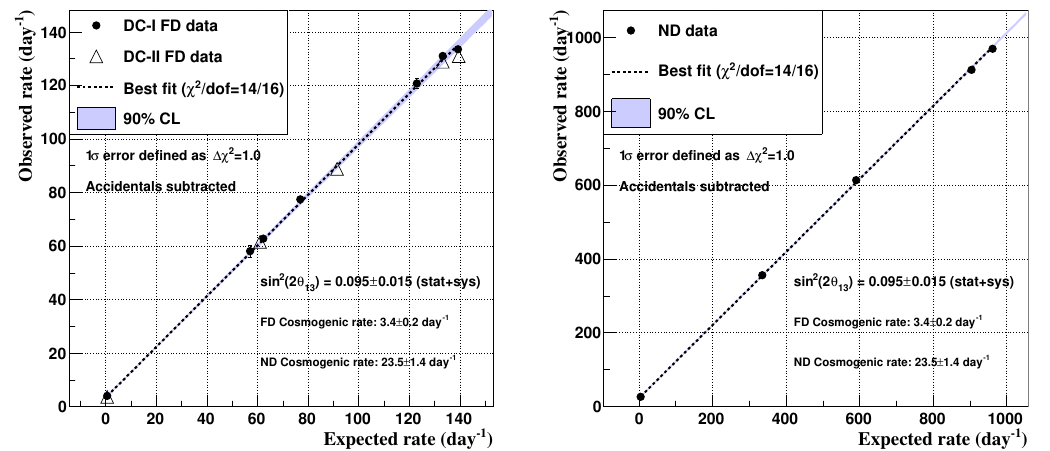
Figure 5 . RRM sin 2 (2 θ 13 ) fit results. The observed rates versus the expected rates in the FD (left) and the ND (right) are shown superimposed to the best-fit model (dashed line). The statistical errors, not visible, are at the level of ∼ 1% ( ∼ 0 . 4% ) in the FD (ND). The parameters B FD and B ND are constrained by the estimates obtained from reactor-on data.